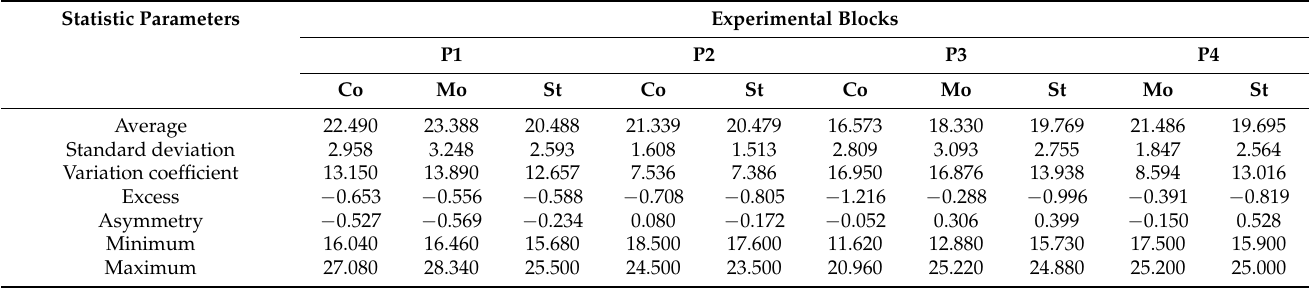
Table 4. The general statistical parameters (average, standard deviation, variation coefficient (%), asymmetry, excess, minim and maximum) for microdrill wood resistance